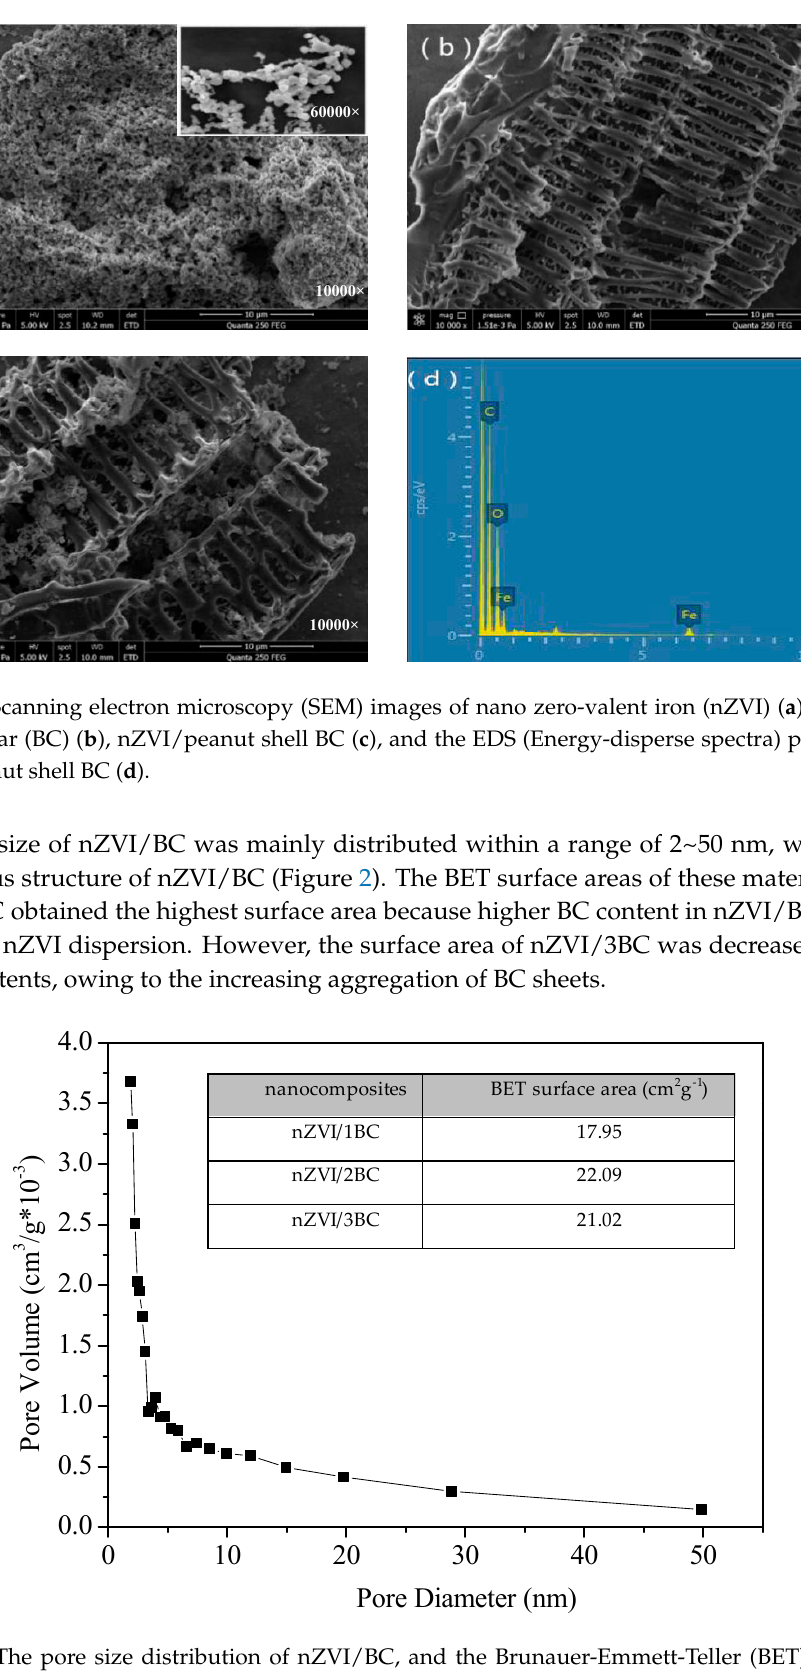
Figure 2. The pore size distribution of nZVI/BC, and the Brunauer-Emmett-Teller (BET) surface area (inset).